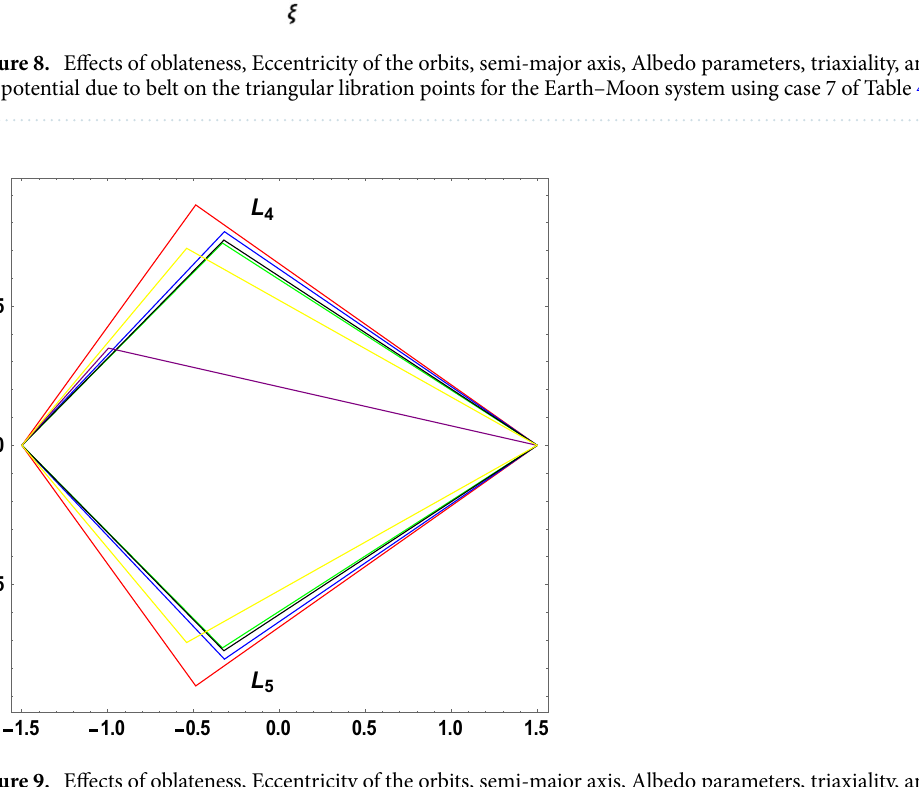
Figure 9. Effects of oblateness, Eccentricity of the orbits, semi-major axis, Albedo parameters, triaxiality, and the potential due to belt on the triangular libration points for the Earth–Moon system using Table